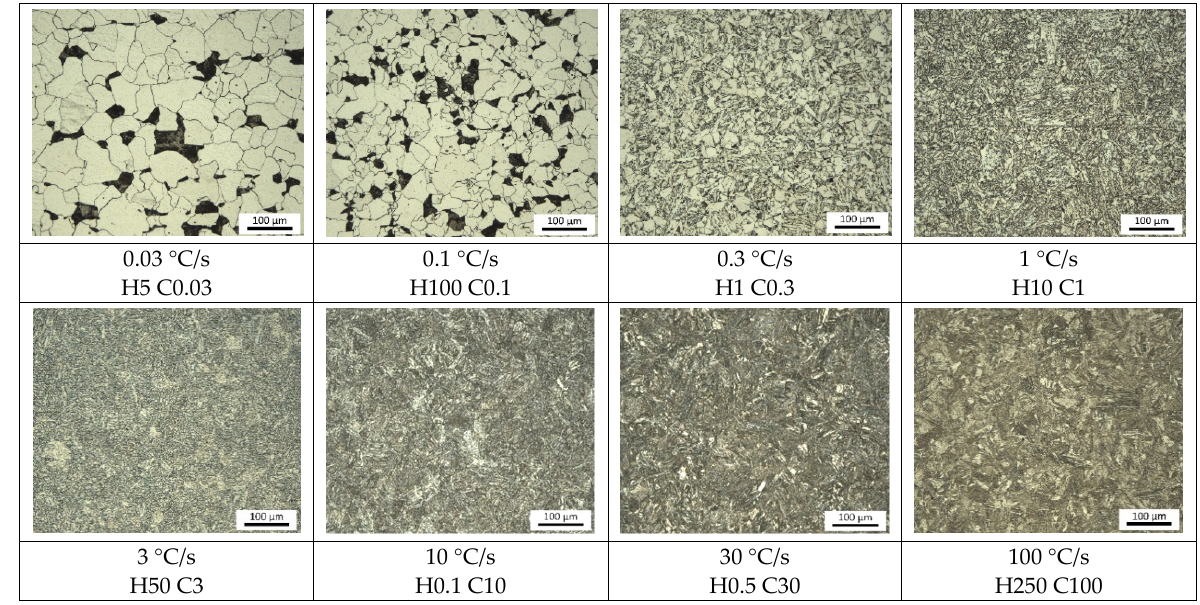
Figure 11. The influence of the cooling rate on the microstructure of S960MC steel.